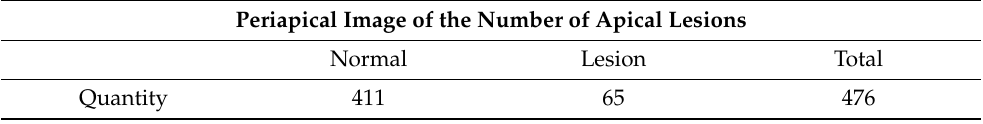
Table 1. Clinical application of the periapical image of the number of apical